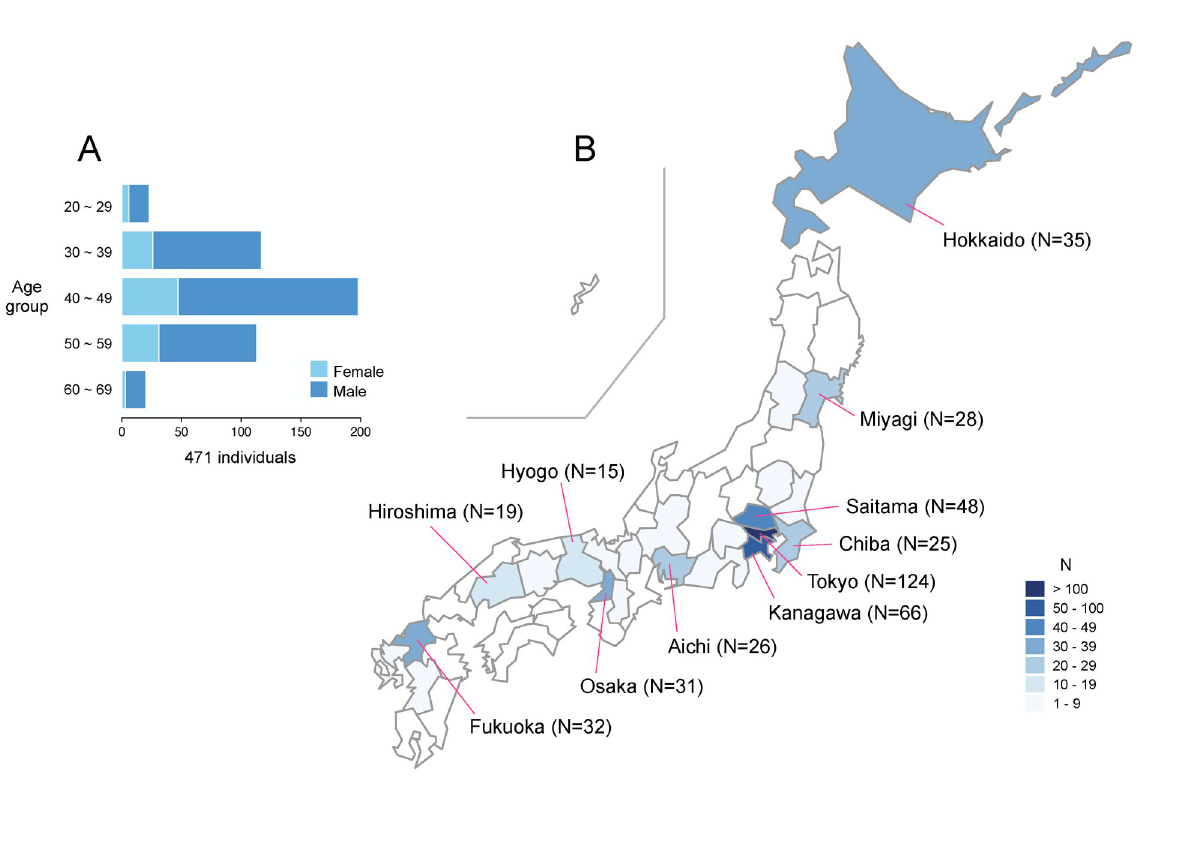
Fig 3. Characteristics of survey participants. (A) Age group distribution with males (blue) and females (light blue). (B) Locations at the time of screening, showing prefectures with more than 10 participants. Plots were generated using the survey result (S2 Table), R (version 4.1.1) and an open-source R package ‘NipponMap’